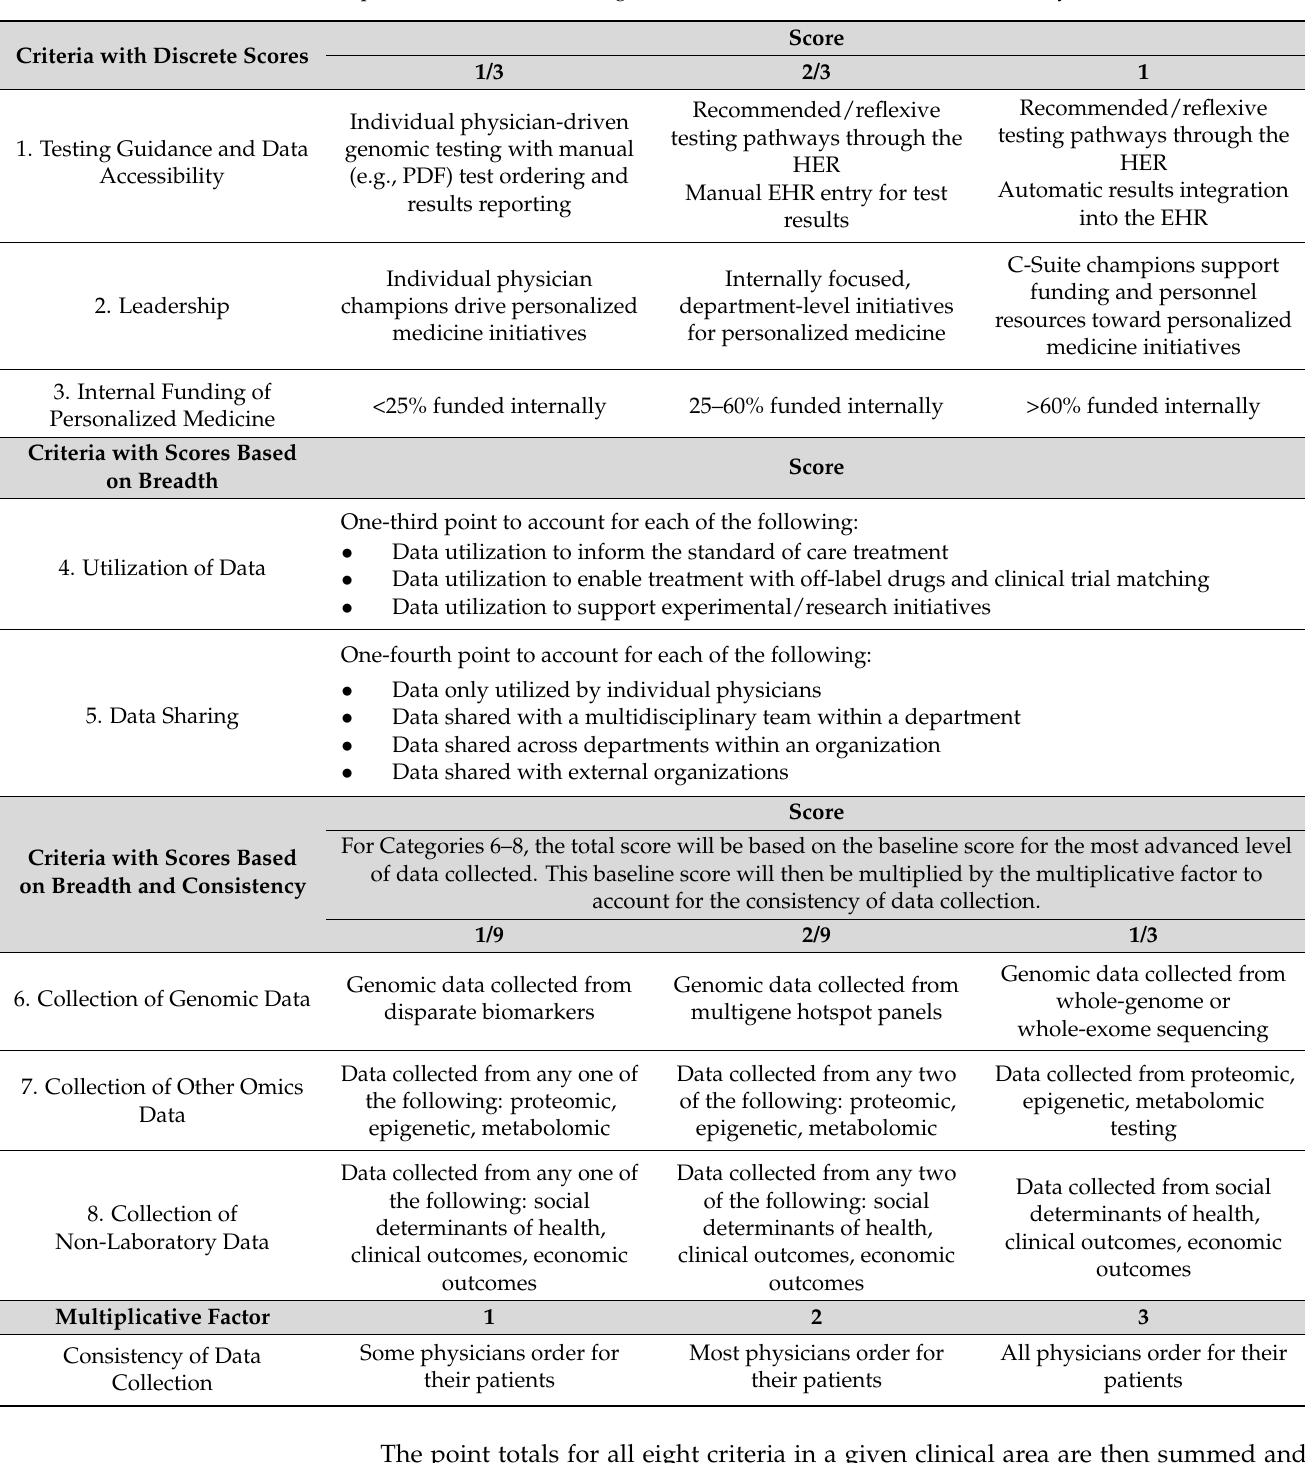
Table 1. Framework to evaluate personalized medicine integration for each of the five clinical areas at every institution